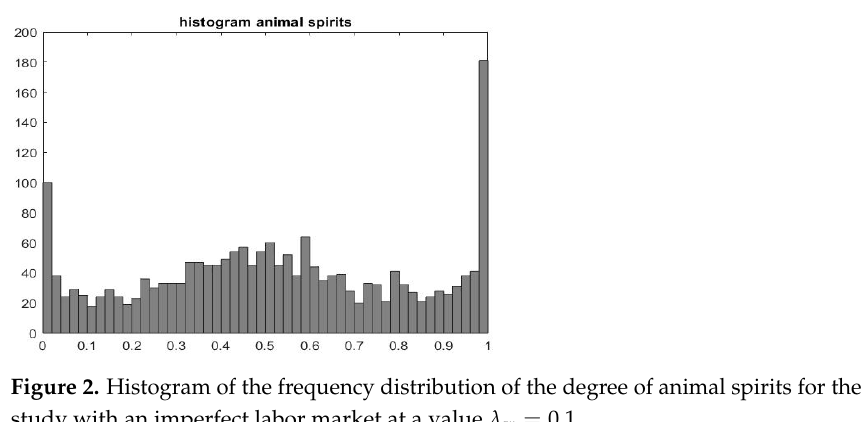
Figure 2. Histogram of the frequency distribution of the degree of animal spirits for the model under study with an imperfect labor market at a value 𝜆 𝑤 = 0.1 .